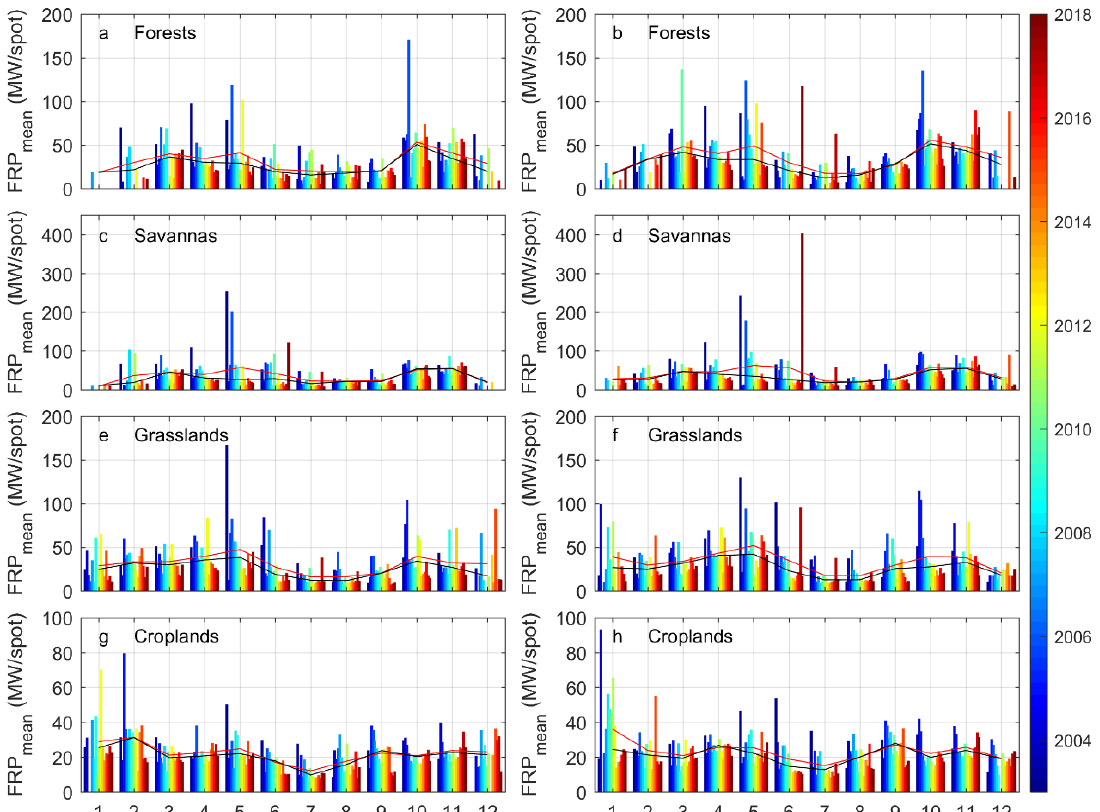
Figure 11. Monthly mean fire radiative power for each fire spot (FRP mean , unit: MW/spot) in different land cover types during 2003–2018 from ( left panel ) Terra and ( right panel ) Aqua fire products. The graphs show the values for ( a , b ) forests, ( c , d ) savannas, ( e , f ) grasslands, and ( g , h ) croplands. The red lines represent the monthly average values, and the black lines represent the median values.